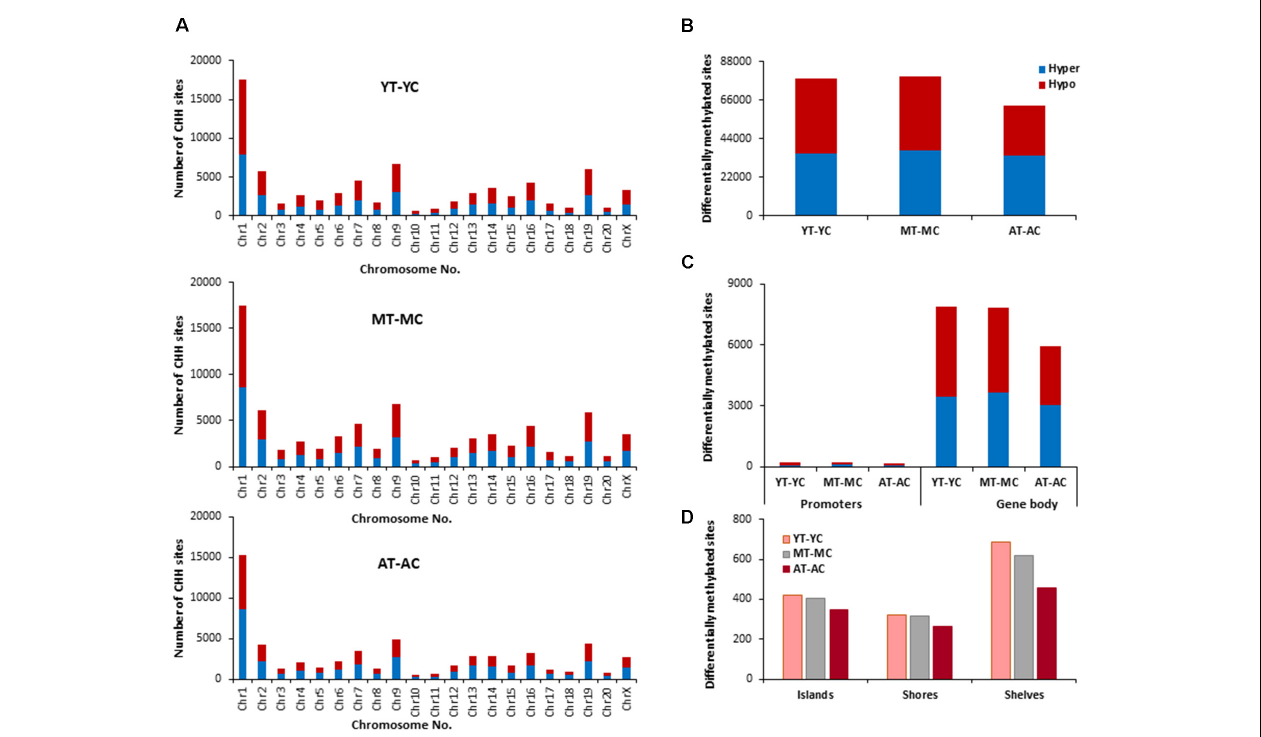
FIGURE 7 | Age-related differences in DNA CHH methylation due to E2-treatment. (A) Differentially methylated CHH sites along the chromosome (1–20) including X-chromosome for each age. The differential methylation was based on a statistical significance of p < 0.01. (B) Total number of differentially methylated CHH sites induced by E2-treatment for each age group. The red bars denote hypomethylation and blue bar denotes hypermethylation for the E2-treatment group relative to the age-matched control group. (C) Number of differentially methylated CHH sites in promoter and gene body regions in E2-treated relative to age-matched controls. (D) Comparison of the differentially methylated CHH sites across the regulatory regions: islands, shores, and shelves.